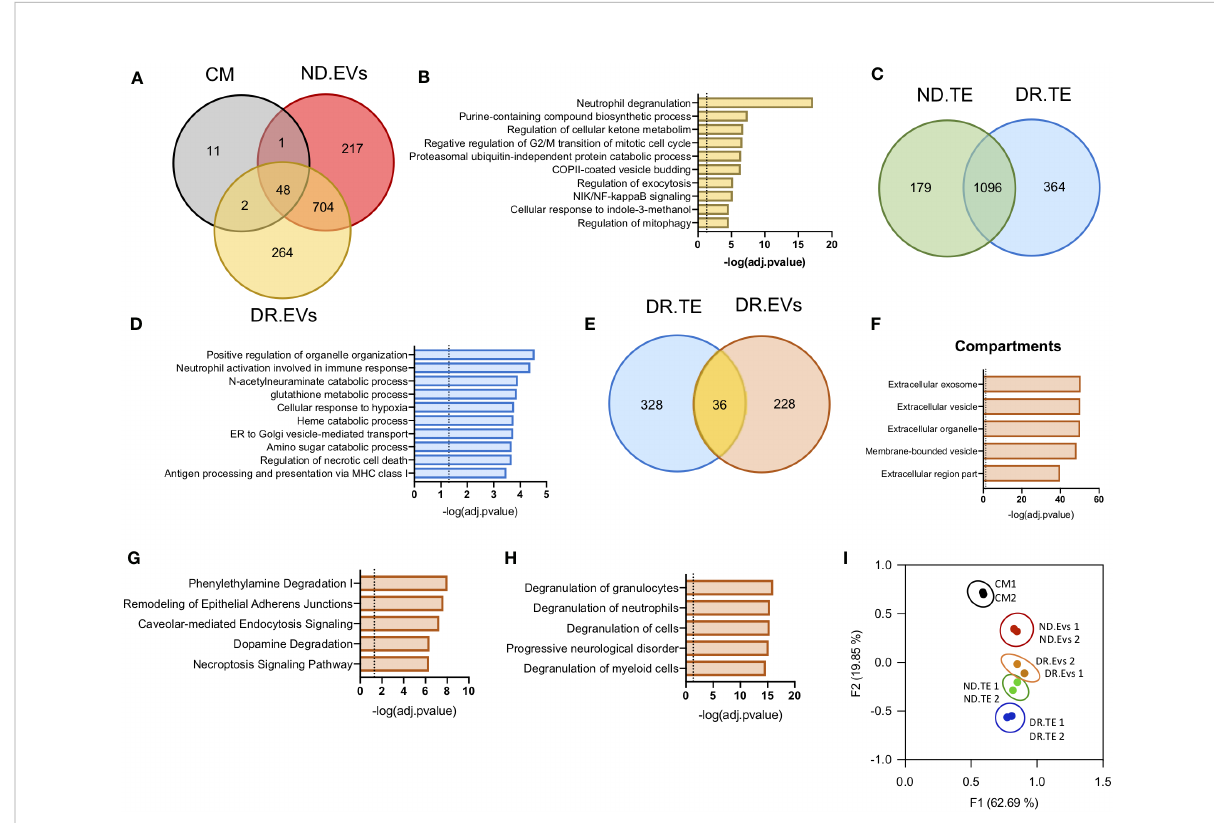
FIGURE 2 Proteomic analysis of EVs released by Diabetic Retinopathy and Non-Diabetic human retinal tissue. (A) Venn diagrams showing protein data set intersections between Control Media (CM) and retinal EVs from Diabetic Retinopathy (DR.EVs) and Non-Diabetic (ND.EVs) patients. (B) Pathway enrichment analysis of exclusive proteins in DR.EVs. (C) Venn diagrams showing shared proteins between retinal tissue explants of non-diabetic (ND.TE) and diabetic patients (DR.TE). (D) Pathway enrichment analysis of exclusive proteins in DR.TE. (E) Venn diagrams of exclusive proteins detected in DR.EVs and in DR.TE. (F) Prediction analysis to determine exclusive DR.EVs protein subcellular localization. Pathway (G) and biological process (H) enrichment analysis of exclusive proteins in DR.EVs. (I) PCA scatter plot comparing the proteomes of Control Media (CM), ND.EVs, DR.EVs, ND.TE and